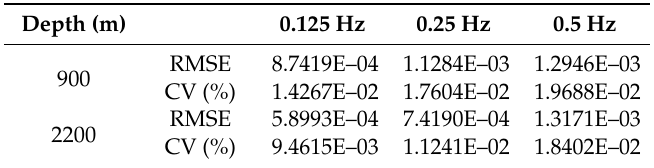
Table 3. RMSE and CV analyses between EM profiles modelled by GP and EM profiles generated through CST software for all frequencies.